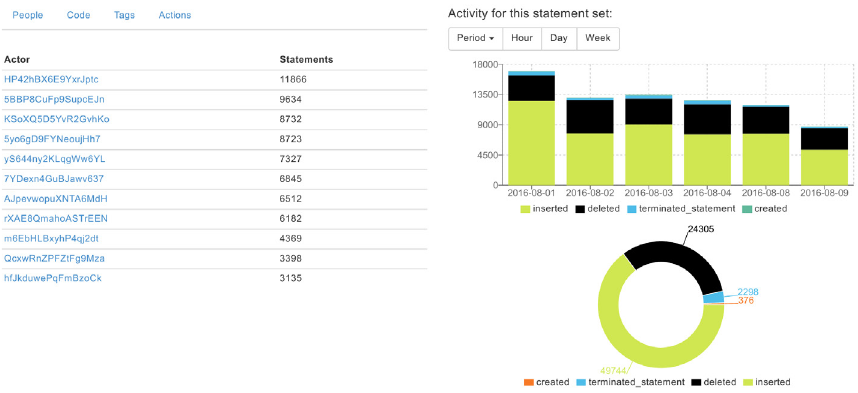
Fig. 2. Screen shot of the learning analytics dashboard. On the left is the data browser, current- ly showing an anonymised list of users; on the right are two visualisations of coding behaviour over the 6 days of the